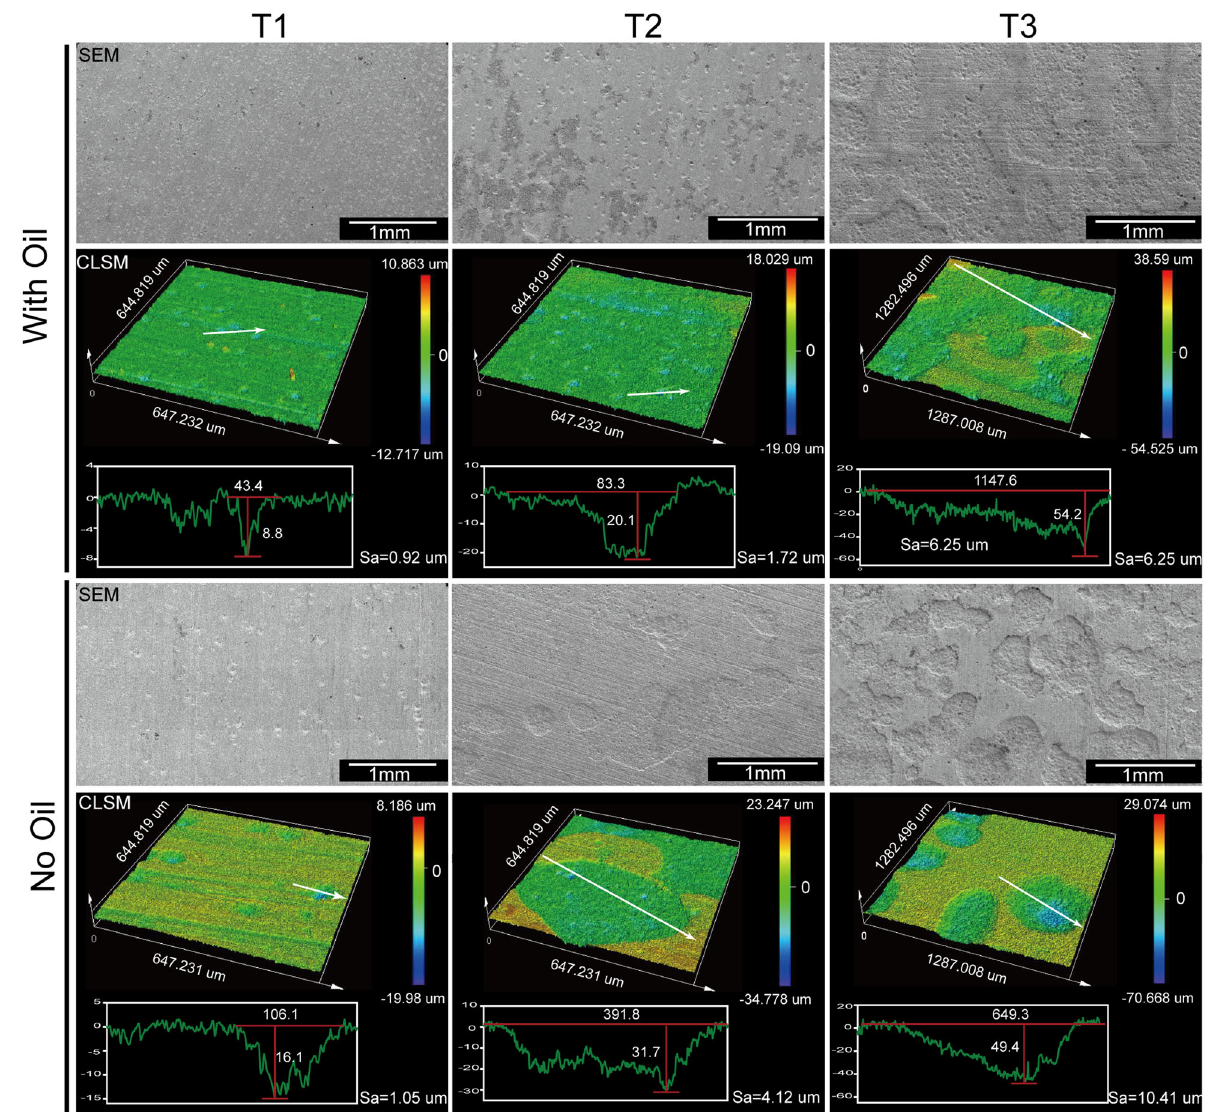
Fig. 3 Morphology of steel in seawater simulators at different culture stages (25, 55 and 85 days) with/without crude oil exposure. Surface morphology of steel samples was visualized using SEM and CLSM techniques after removing the corrosion products. Sa: Roughness coef fi cient. “ With Oil ” : With crude oil amendment; “ No Oil ” : Without crude oil. T1: 25 days; T2: 55 days; T3: 85